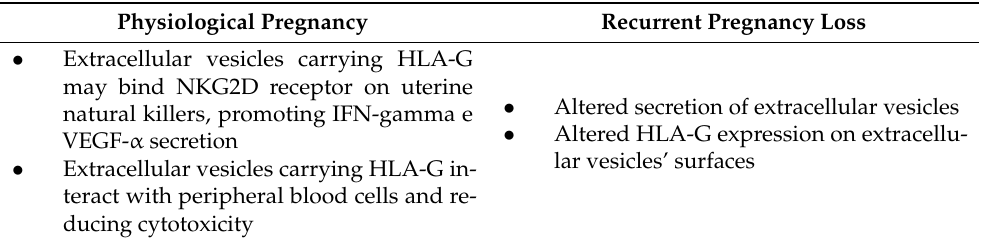
Table 2. Extracellular vesicles carrying HLA-G roles in physiological pregnancy and in recurrent pregnancy